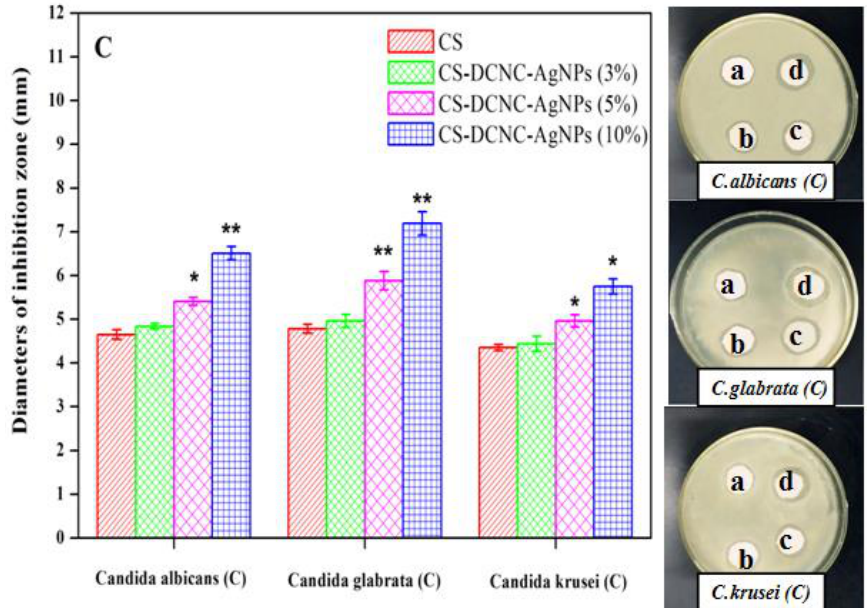
Figure 4. Antibacteria activity of CS-DCNC-AgNPs: ( A ) Gram-positive bacteria, ( B ) Gram-negative bacteria, ( C ) fungi. The meaning of the letter in the inset is: ( a ) CS, ( b ) CS-DCNC-AgNPs (3%), ( c ) CS-DCNC-AgNPs (5%), ( d ) CS-DCNC-AgNPs (10%).